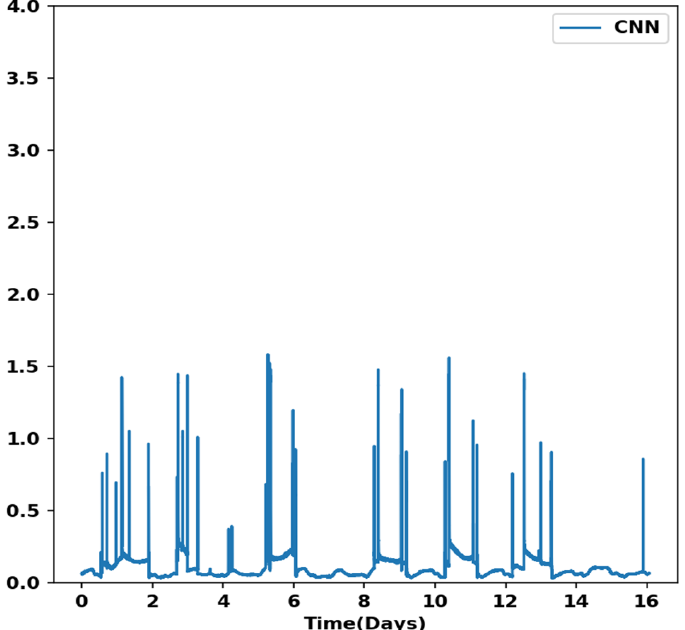
Figure 10. Comparison between the reconstructed signal of the CNN autoencoder and the original signal.